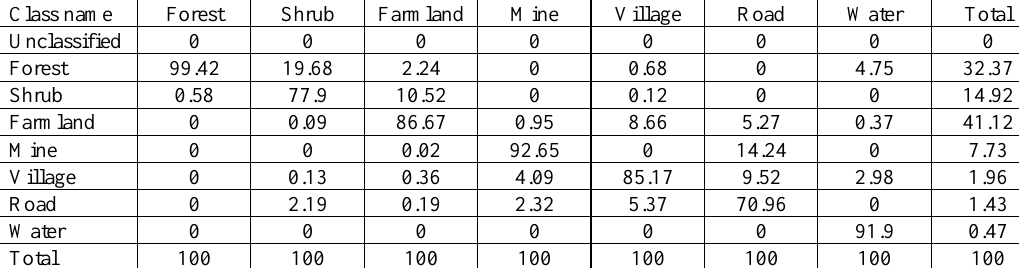
Table 6. Confusion matrix and accuracy assessment of object-based RF